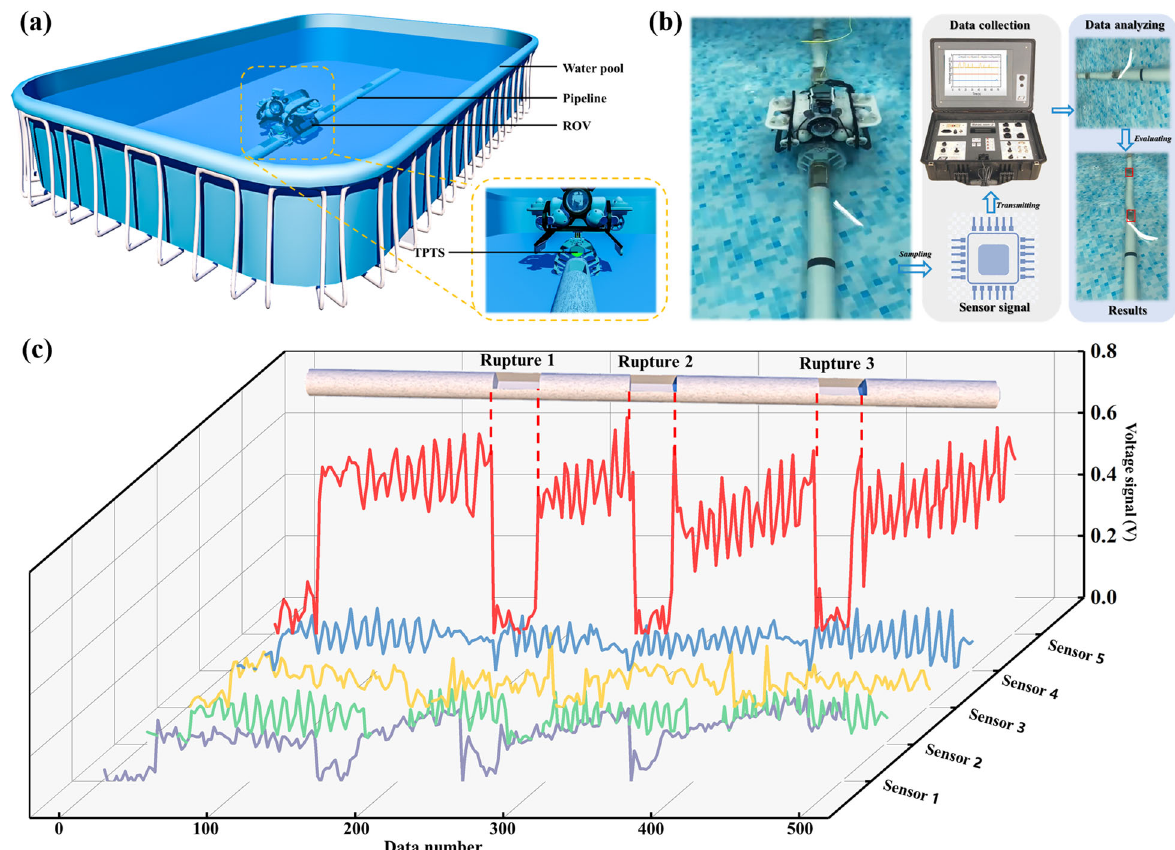
Fig. 7 Experiments with non-destructive underwater pipeline evaluation. a The con fi guration of the pipeline and sensors in use of non- destructive underwater pipeline evaluation. b The process fl ows from signal sampling to non-destructive underwater pipeline evaluation. c Demonstration of TPTS in non-destructive underwater pipeline evaluation and its corresponding output voltage